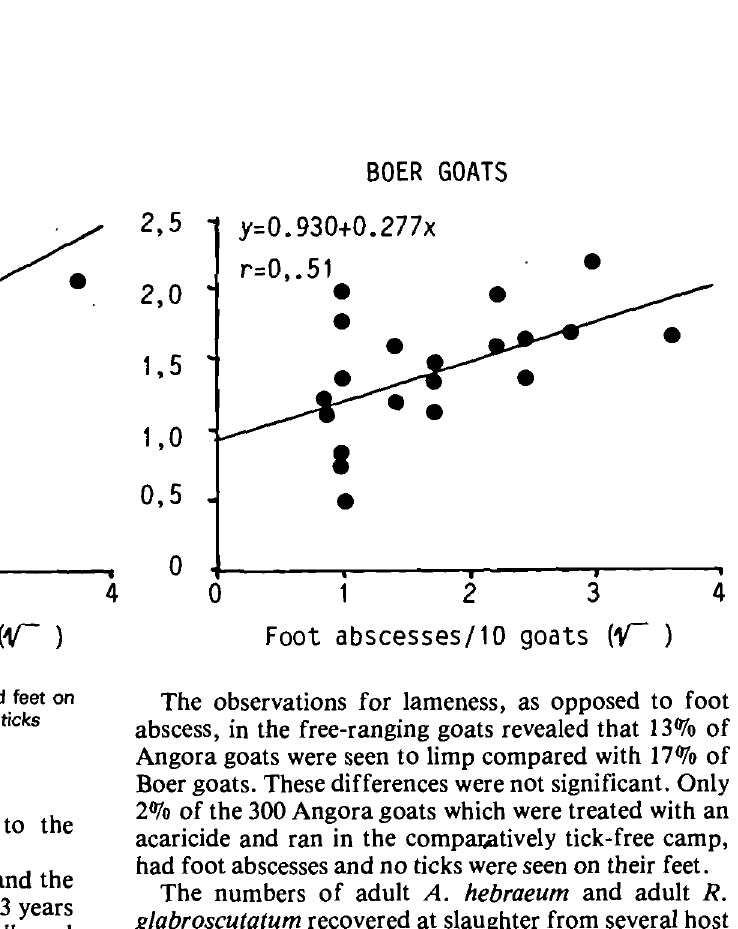
The number of abscessed feet in relation to the number of adult ticks is shown in Fig.